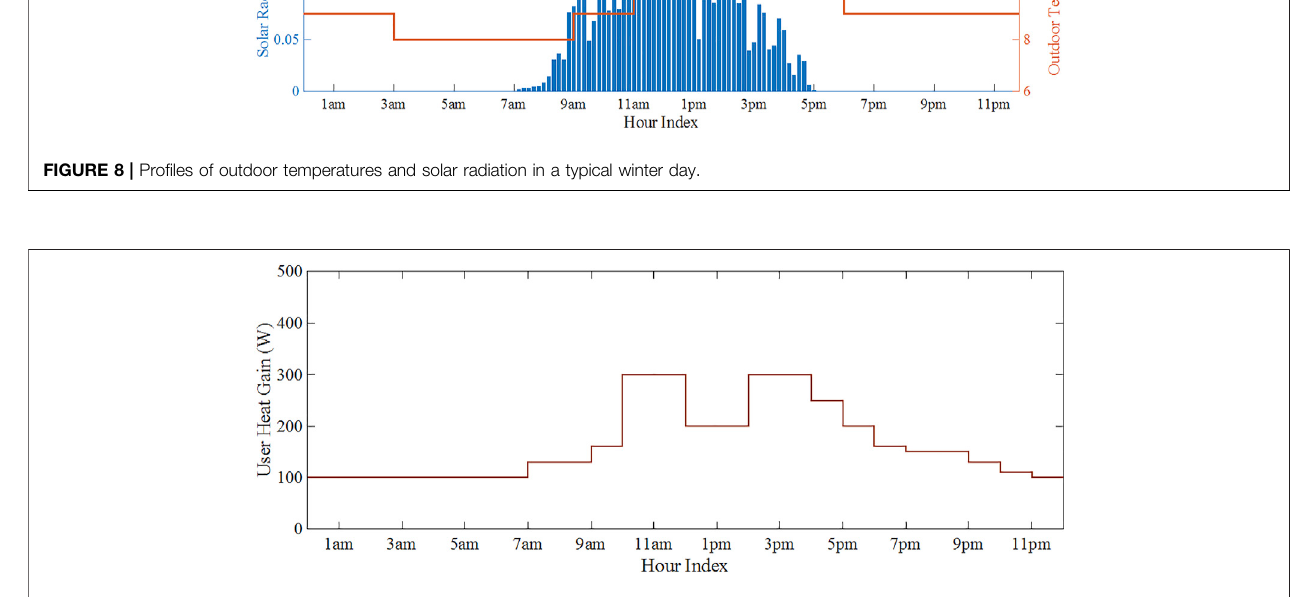
FIGURE 9 | Heat gain released by the occupant.